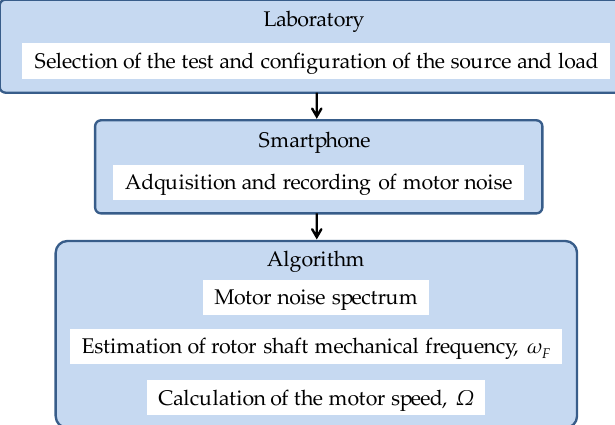
Figure 2. General scheme of the procedure followed to estimate the rotor speed.